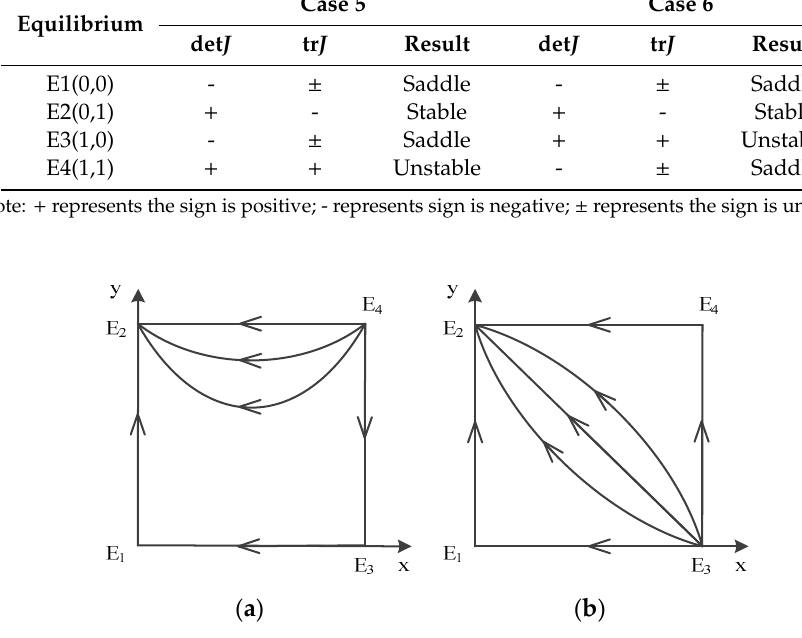
Figure 5. Diagram on dynamic evolution of equilibrium points in E 2 ( 0,1 ) , ( a ) Case 5 ( b ) Case